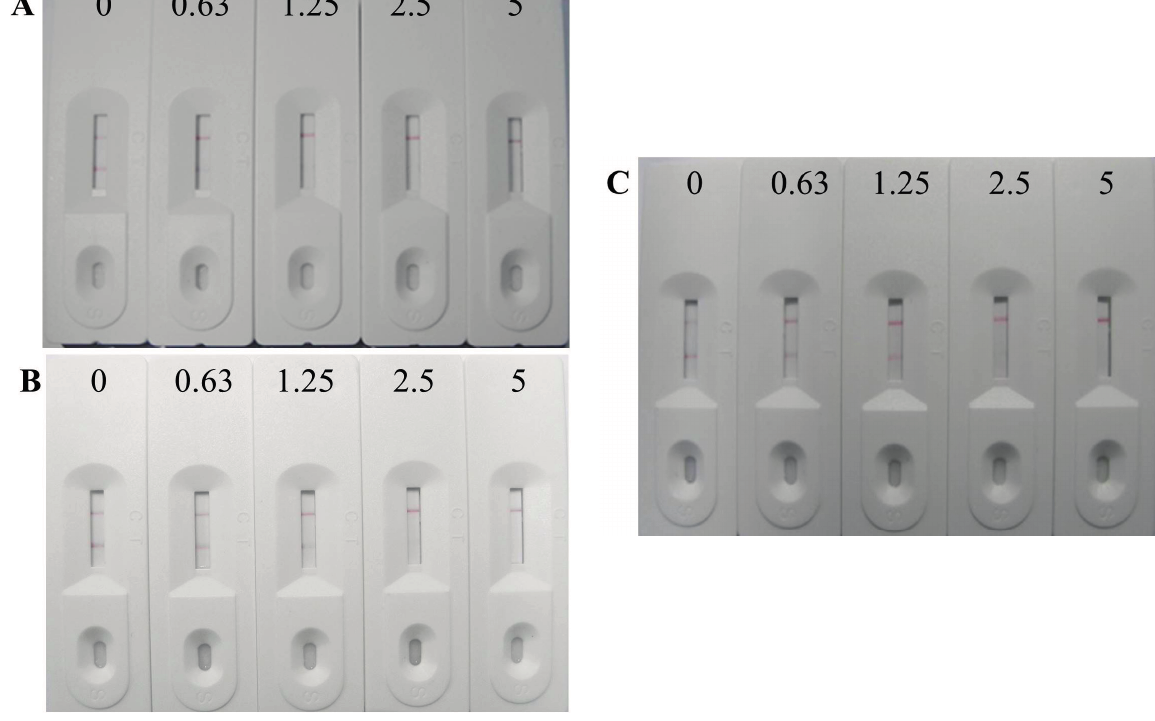
Figure 3. Photograph of the immunochromatographic strip for MT detection in PBS ( A ); fish feed ( B ) and pig feed ( C ). The concentrations of MT from left to right were 0, 0.63, 1.25, 2.5, and 5